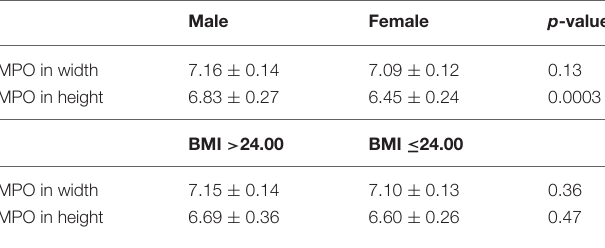
Frontiers in Surgery |